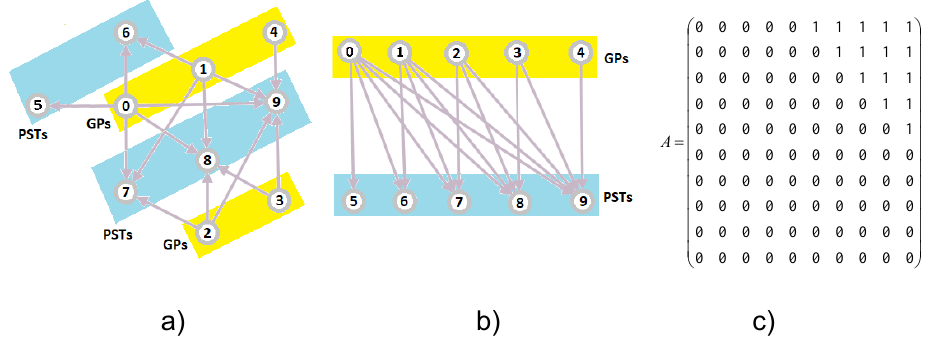
Figure 4 – Directed graphs (a, b) and graph adjacency matrix or the connection matrix (c) Рис . 4 – Направленные графы (a, b) и их матрица смежности (c) Слика 4 – Усмерени графови (a, b) и матрица повезаности графа